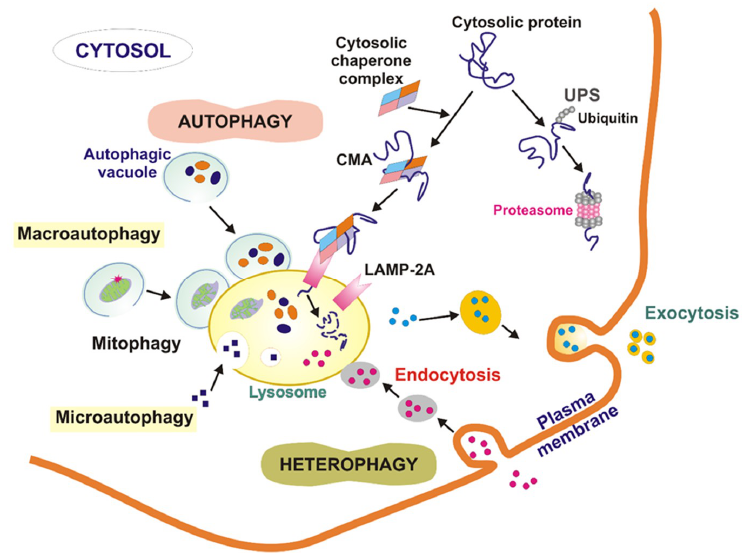
Figure 5. Cellular and extracellular waste clearing. Cellular waste, including misfolded, aggregated and damaged proteins as well as damaged organelles (presented as small ovals or squares of different colors) is subjected by two main machineries: ubiquitin-proteasome system (UPS) and autophagy, which can be in the form of macroautophagy, including mitophagy, microautophagy and chaperone- mediated autophagy (CMA). Unfolded proteins are a substrate for unfolded protein response (UPR, not represented here), which directs them to degradation either by autophagy or UPS. Heterophagy, which degrades extracellular debris inside the cell, is of a particular importance in retinal pigment epithelium cells and is usually carried out by endocytosis. Exosomes can transport waste material out of the cell. LAMP-2A—lysosomal associated membrane protein 2A. The black arrows indicate the sequence of events.